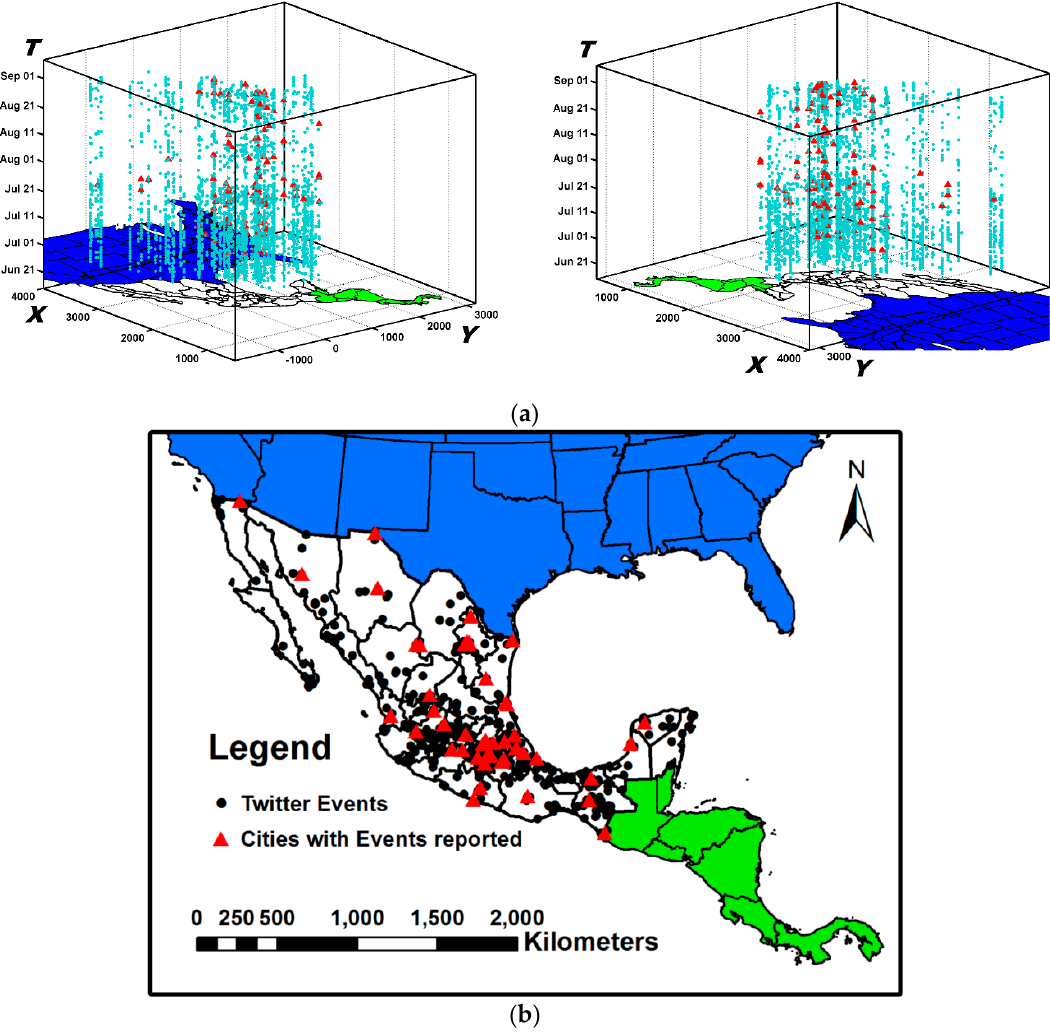
Figure 9. The STTE related to civil unrest in Mexico from June 21 to September 1. ( a ) spatio-temporal distribution viewed from two different perspectives; ( b ) the corresponding STE obtained by spatial projection of the spatio-temporal Twitter events.